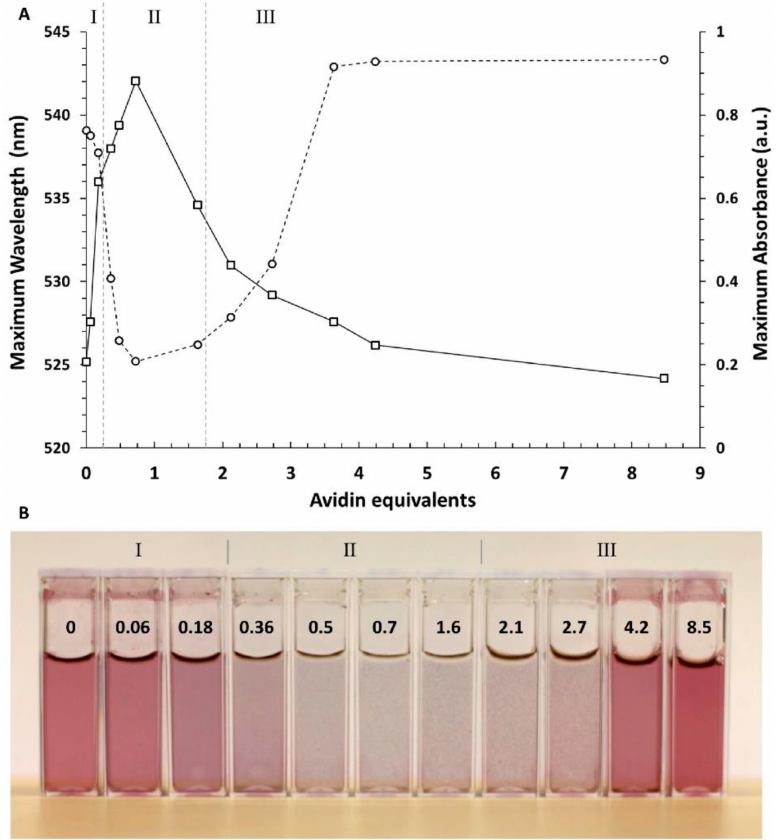
Figure 5. ( A ) Position of the maximum of the SPR band (left axis, squares and solid line) and its absorbance intensity (right axis, circles and dotted line) of AuNP2 upon addition of increasing amounts of avidin; ( B ) The change of color of selected cuvettes following the addition of avidin (equivalents shown on each cuvette, values above 0.36 have been rounded for clarity). Each cuvette represents an independent experiment. Notice the presence of some precipitate in samples 0.36–2.7 (see text for